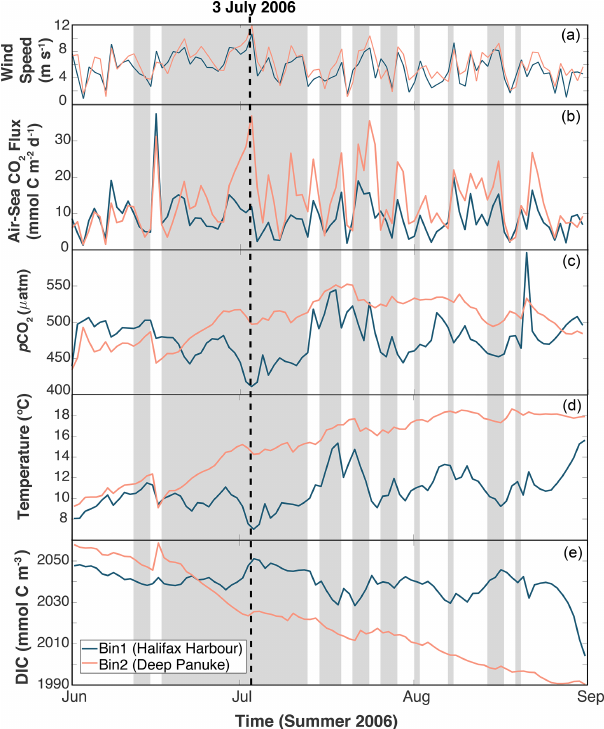
Figure 5. Time series of variables in two bins along the Atlantic Condor transect (see Fig. 1) during summer 2006. From panel (a) to (d) : (a) wind speed, (b) air–sea CO 2 flux, (c) p CO 2 , (d) tem- perature, and (e) dissolved inorganic carbon (DIC). Shaded area indicates when there was upwelling-favourable winds near shore (Bin 1). The blue lines indicate the values from the nearshore bin closest to the Halifax Harbour, and the pink lines indicate values from the offshore bin near the Deep Panuke oil platform.